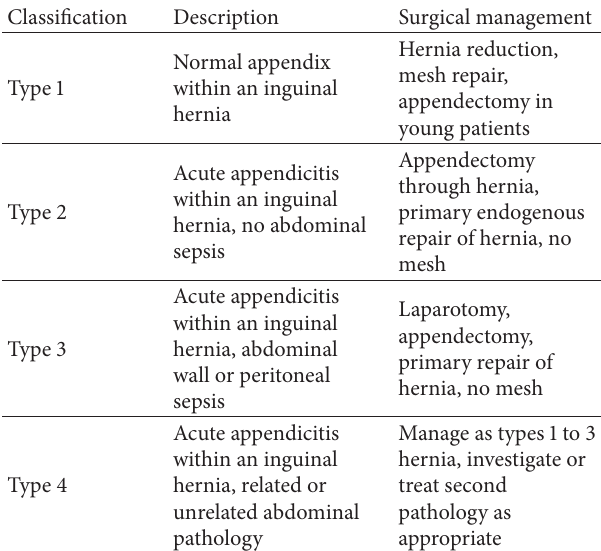
Table 1: Classification of Amyand’s hernias after Losanoff and Basson [3,